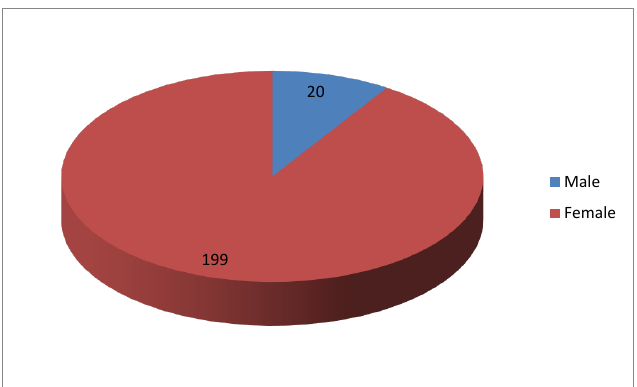
Figure 1. Demographics (gender) (n = 219) of participants. Figure 2 indicates the participants ’ age, ranging from 18 – 24 years, with a mean age of 21.4 years.